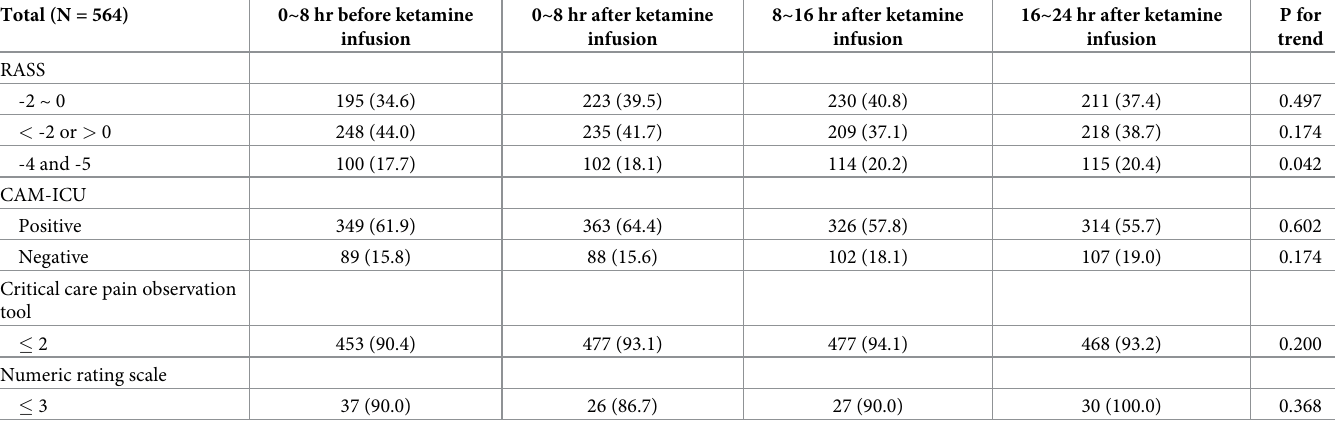
Table 4. Pain, agitation, and sedation trends during continuous ketamine